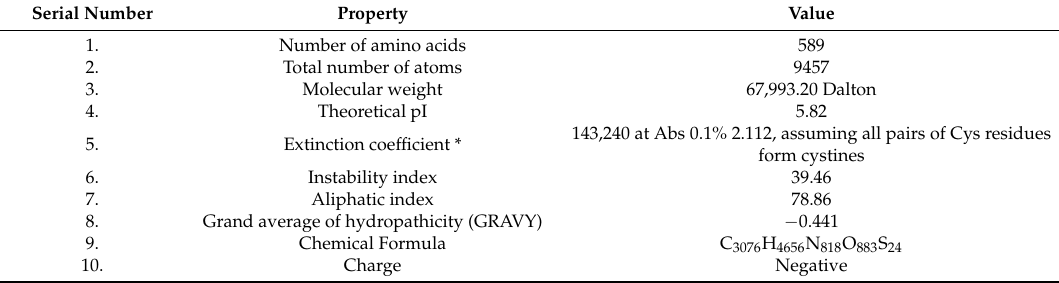
Table 3. Physiochemical properties of ACE predicted by ProtParam.